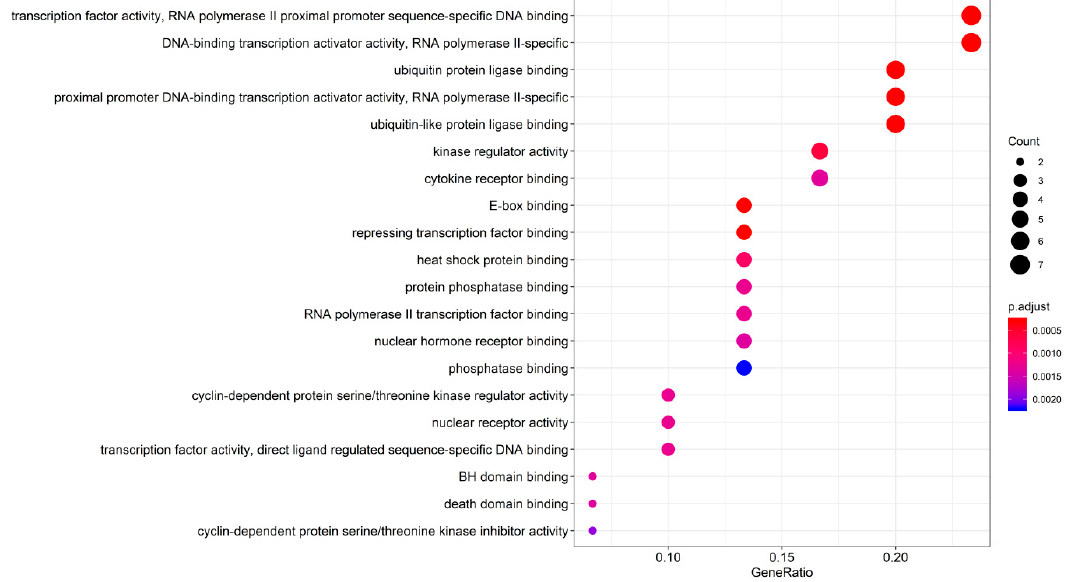
Figure 4. Gene enrichment (GO) analysis for the 30 shared HDW compound targets / PCa-related targets. The color represents the di ff erent adjusted p -values ( < 0.05), while the size of the circle represents the count. Table 3. Enrichment results.